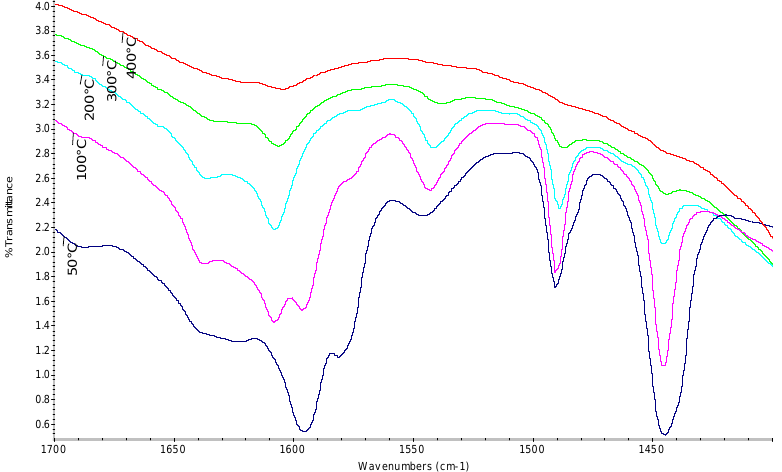
Figure 5. IR spectra of desorption of pyridine from SZ.